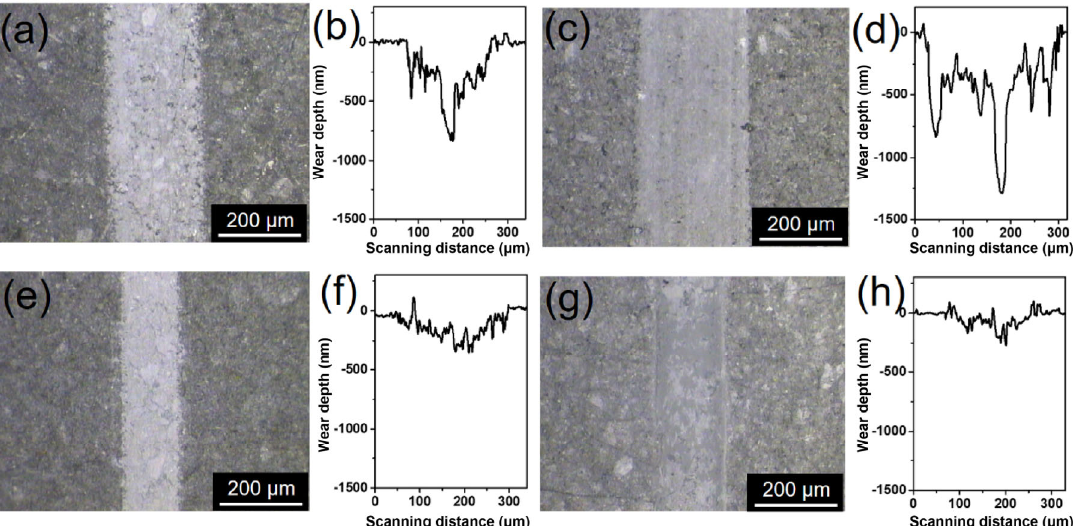
Fig. 4 Optical micrographs and cross sections of wear tracks under a load of 8 N: non-impregnated graphite at 20 °C (a, b) and at 160 °C (c, d); impregnated graphite at 20 °C (e, f) and 160 °C (g,